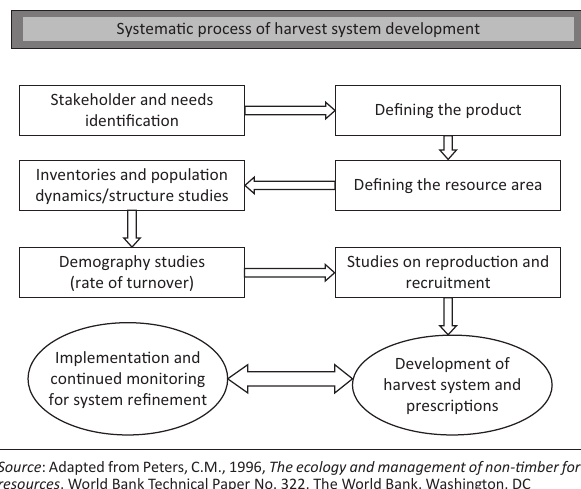
FIGURE 1: Flow diagram indicating the generic process for the development of harvest systems and management prescriptions for sustainable resource use.